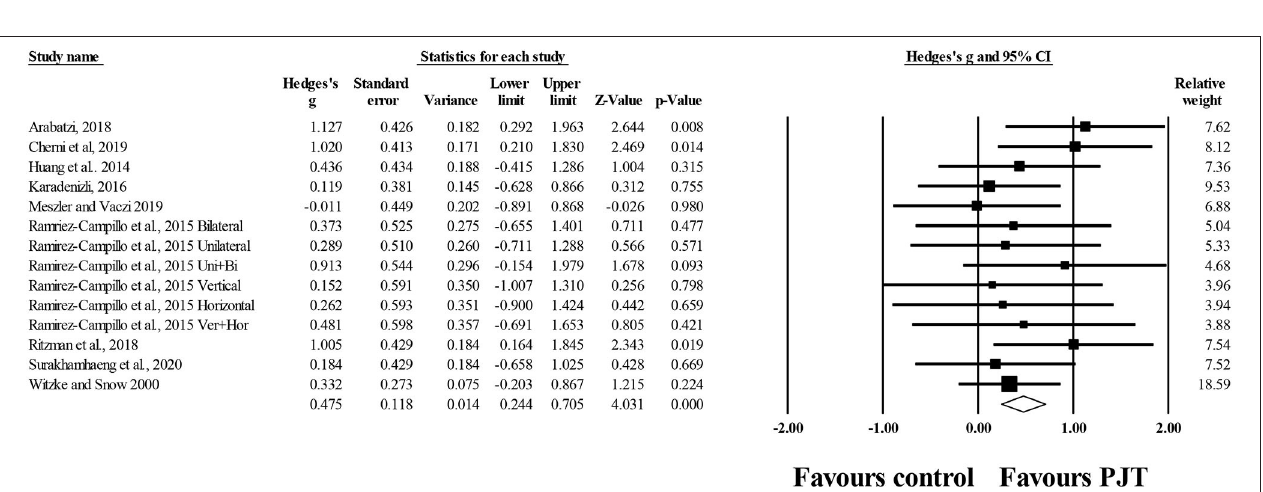
FIGURE 7 | Forest plot of changes in static balance, measured through field-based tests, in participants that completed a plyometric jump training (PJT) program compared to participants allocated as controls. Values shown are effect sizes (Hedges’s g) with 95% confidence intervals (CI). The size of the plotted squares reflects the statistical weight of each study. The diamond reflects the overall result.